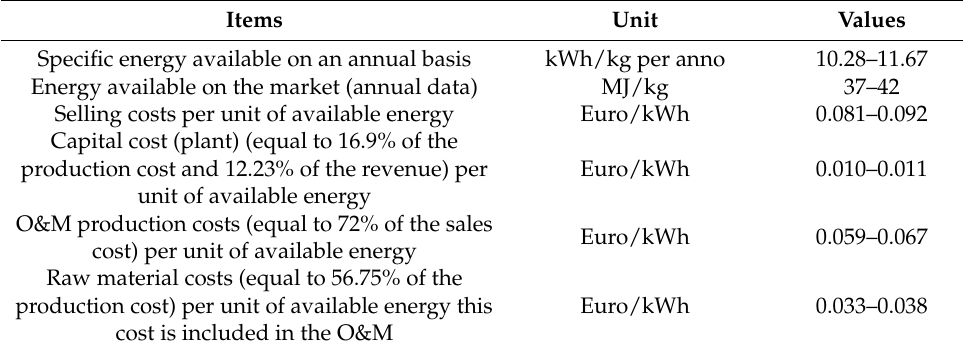
Table 4. Production costs of biodiesel from waste vegetable oil in the individual items, per unit of available energy